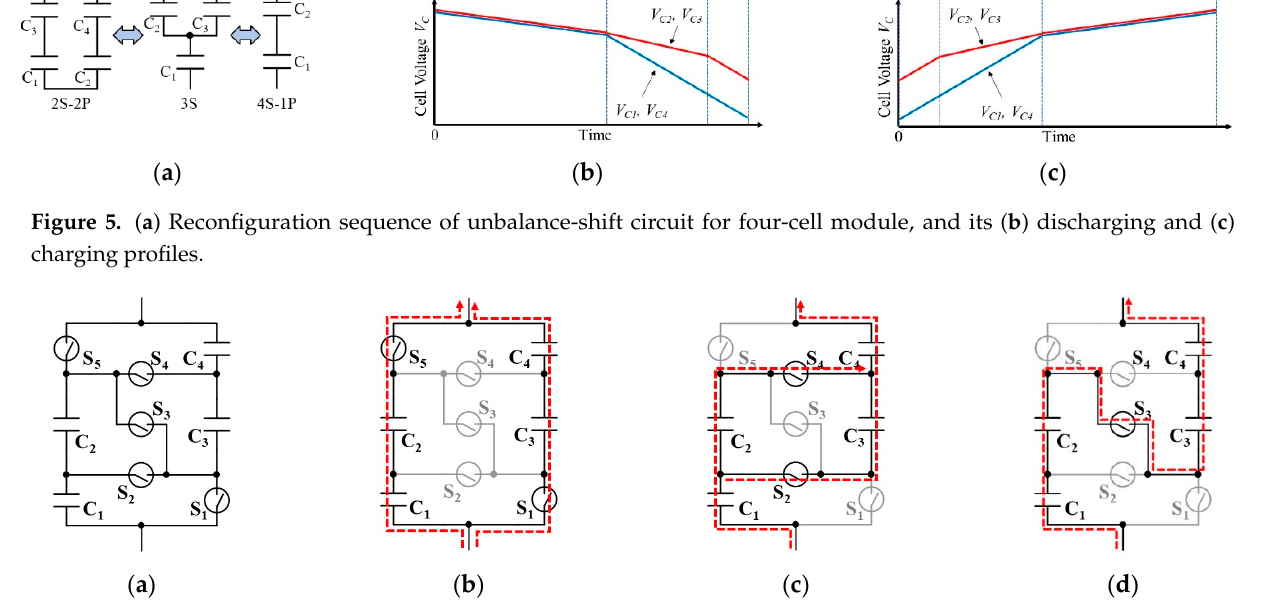
Figure 6. Unbalance-shift circuit for ( a ) four cells. Operation modes in ( b ) 2S-2P, ( c ) 3S, and ( d ) 4S-1P.